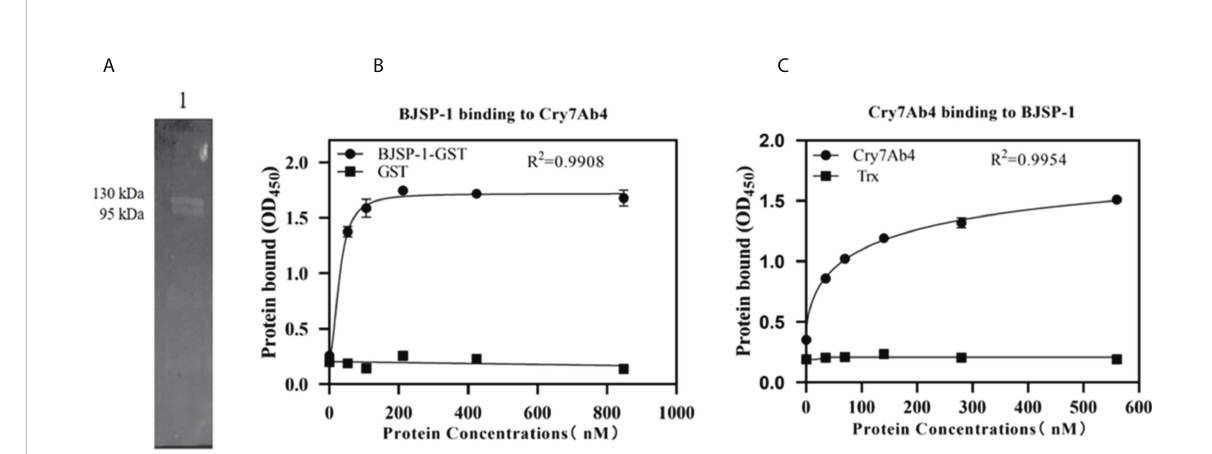
FIGURE 4 In vitro interaction between recombinant BJSP-1-GST and Cry7Ab4 toxic core. (A) Far-Western blot analysis of Cry7Ab4 binding to BJSP-1. Recombinant BJSP-1-GST was separated on SDS-PAGE and transferred to nitrocellulose membrane; the membrane was probed with His- tagged Cry7Ab4 toxic core, and binding of Cry7Ab4 to BJSP-1-GST was detected with mouse anti-His polyclonal antibody. (B, C) Binding of BJSP-1 to Cry7Ab4 (B) and Cry7Ab4 to BJSP-1 (C) by enzyme-linked immunosorbent assay (ELISA). Microtiter plates were coated with Cry7Ab4 toxic core (B) or BJSP-1-GST (C) ; increasing concentrations of BJSP-1-GST or GST (control) (B) and Cry7Ab4 or Trx (control) (C) were added to protein-coated plates, and binding of the two proteins was detected by rabbit anti-GST polyclonal antibody to BJSP-1-GST (B) or mouse anti-His polyclonal antibody to Cry7Ab4 (C) .